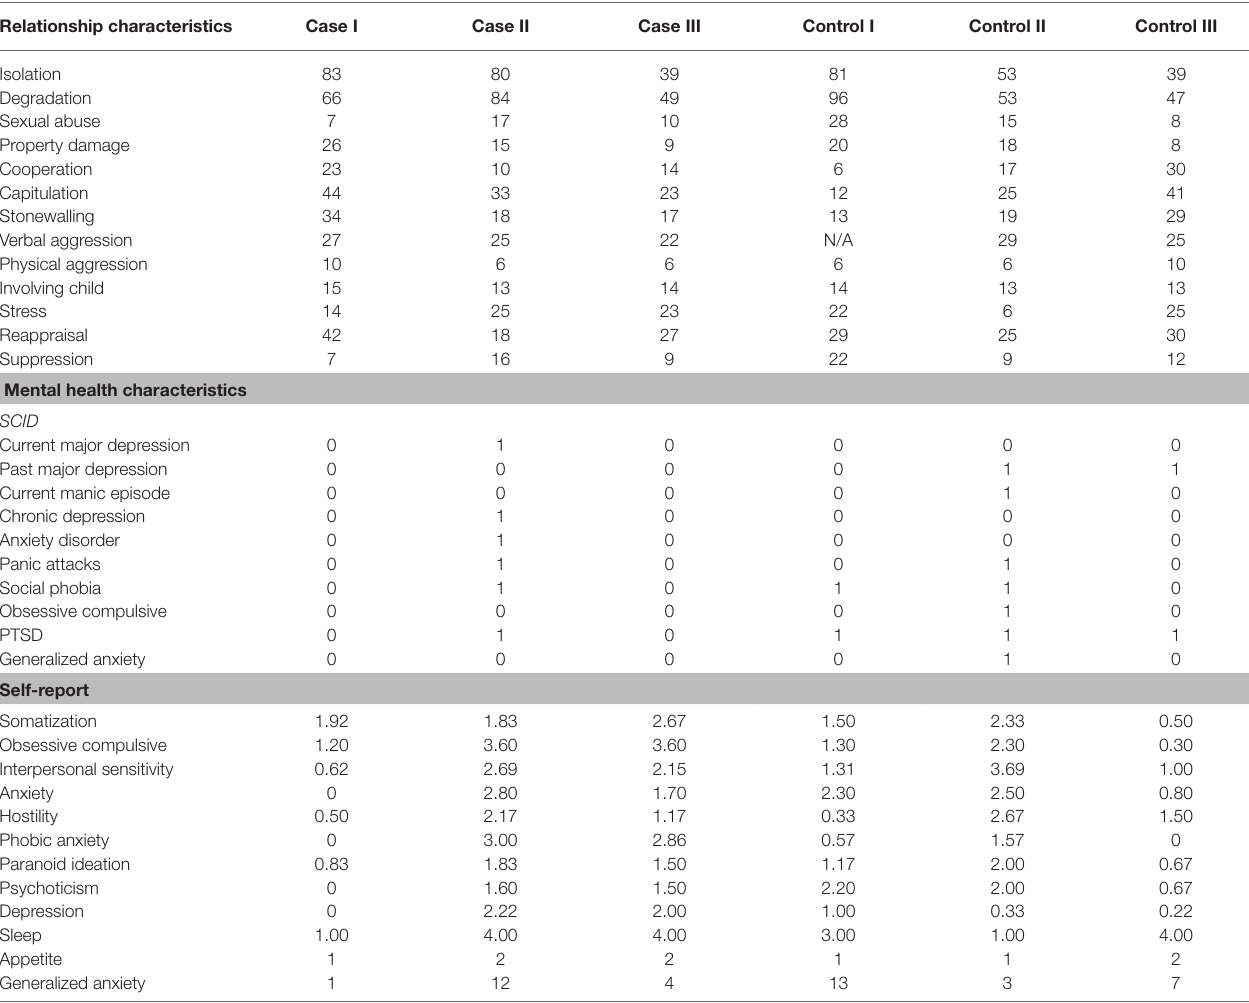
TABLE 1 | Relationship characteristics for the participants. Relationship